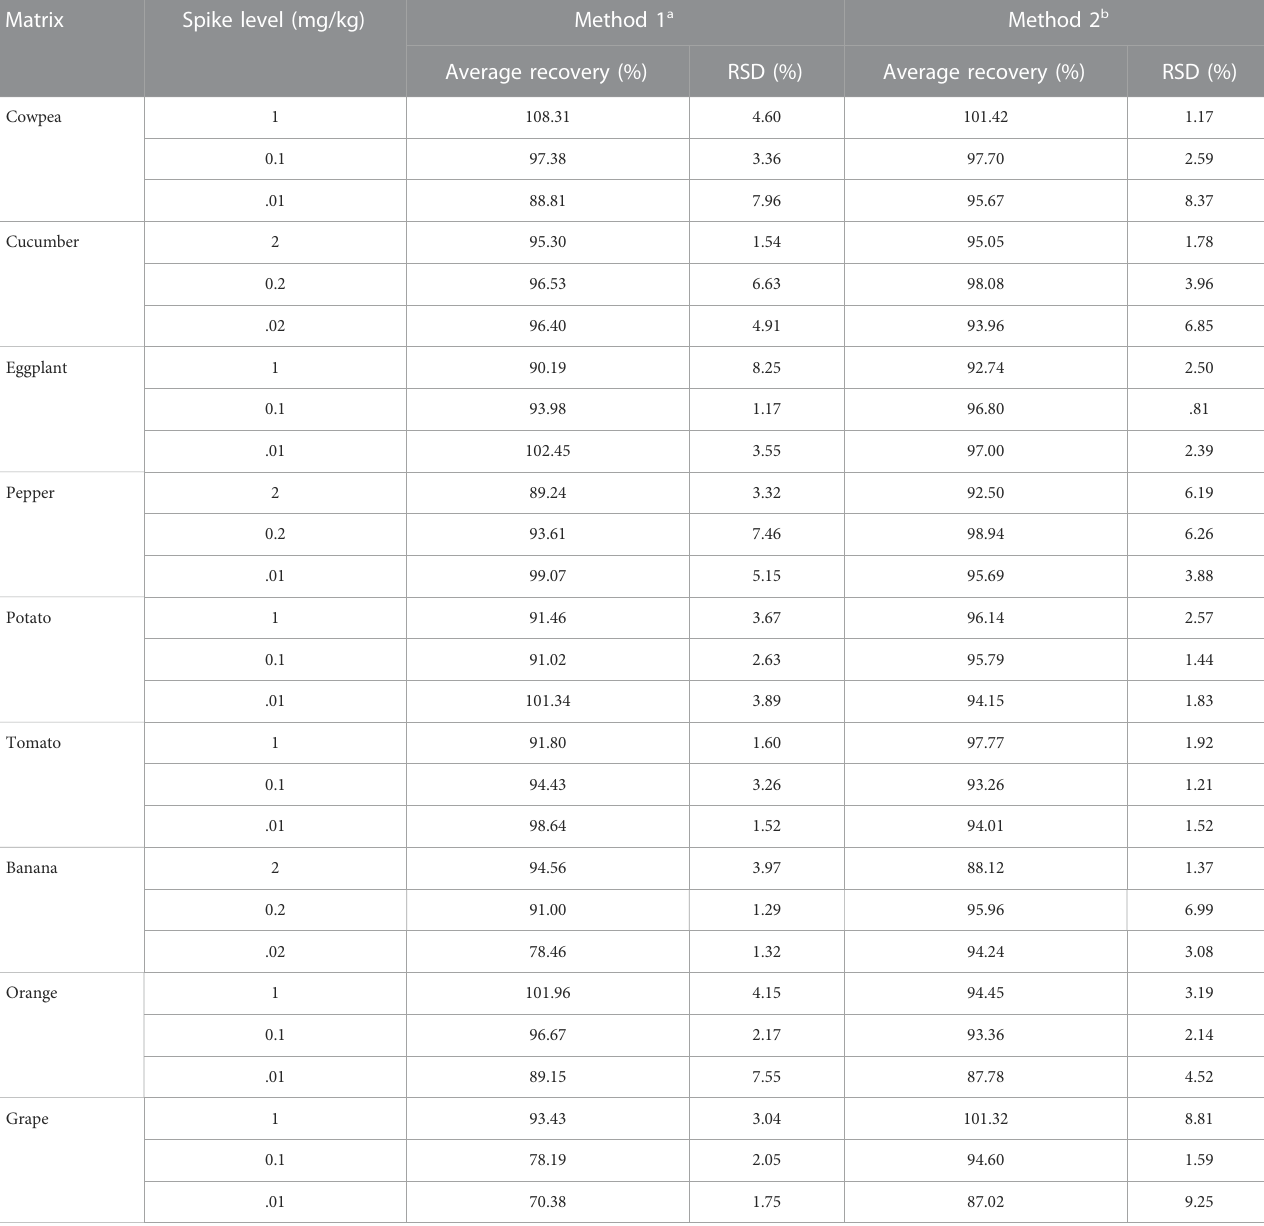
TABLE 2 Spiked recoveries and relative standard deviations (RSD) for fl uopyram ( n = 3).